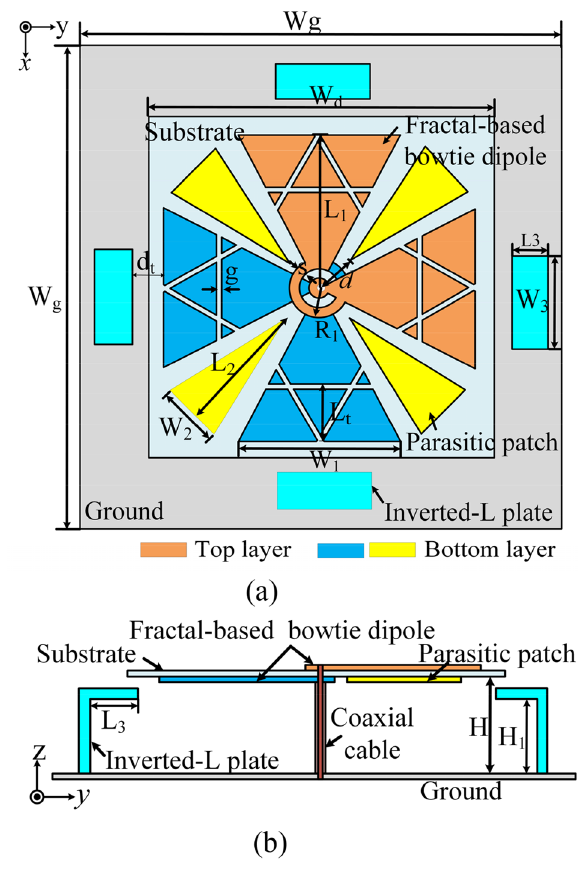
g = 0.5 mm, L2 = 16.9 mm, W2 = 8 mm, d = 4.6 mm, dt = 4 mm, W3 = 10 mm, L3 = 5.5 mm, H1 = 9.3 mm, H = 10.8